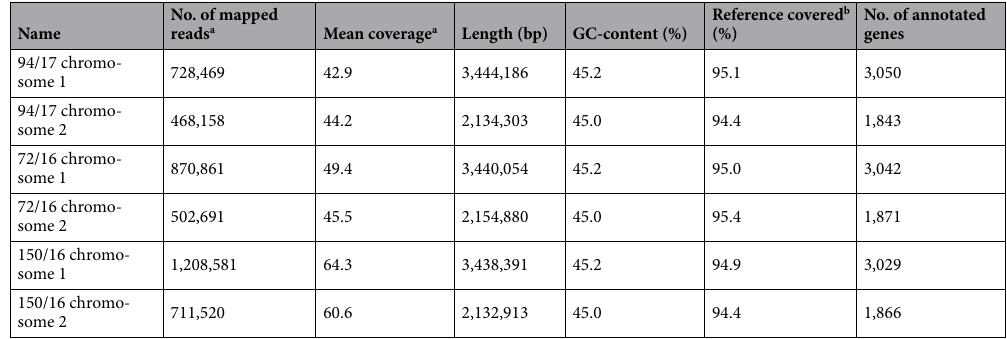
Table 3. Parameters of the consensus whole genome sequences. a,b In relation to V. harveyi strain ATCC 33,843.